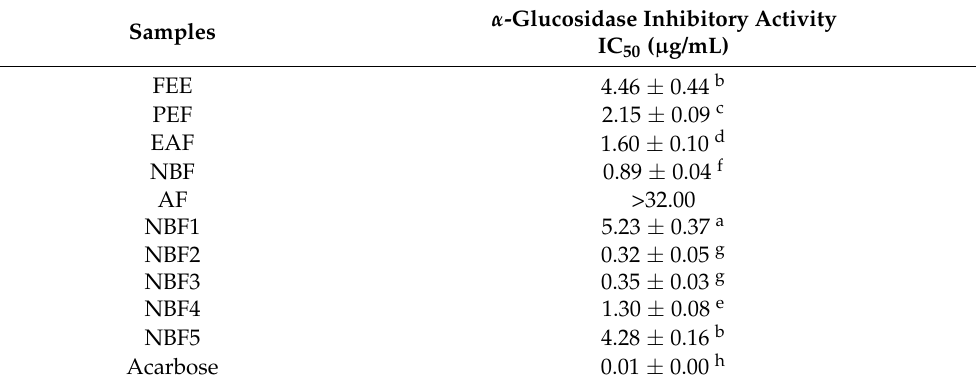
Table 2. α -Glucosidase inhibitory activities of extract and fractions from Ficus tikoua .